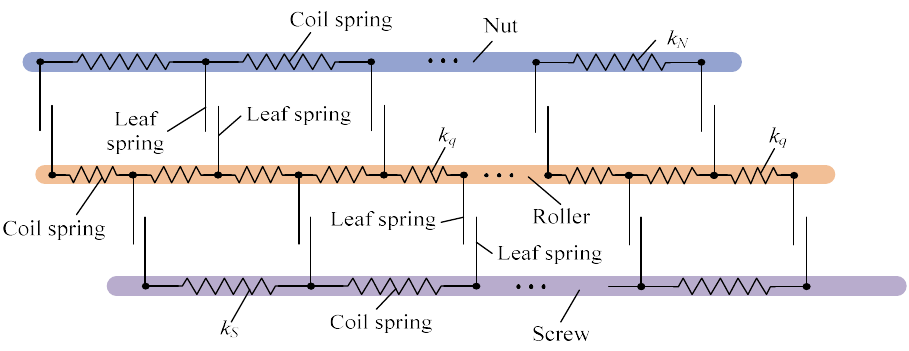
Figure 11. Load distribution calculation model in Ref. [51].